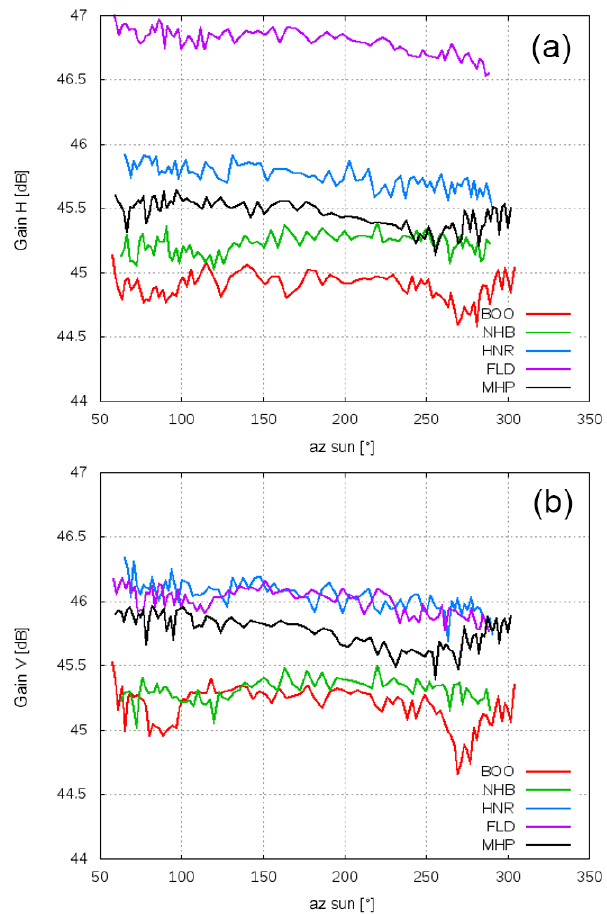
Figure 21. Diurnal gain estimates as a function of solar az- imuth from five radar systems, Boostedt (BOO), Flechtdorf (FLD), Hanover (HNR), Neuheilenbach (NHB) and Hohenpeißenberg (MHP). Shown is the gain of the horizontal receive channel (a) and vertical receive channel (b) . The time series shown here are based on about 90 box scans that are available for each